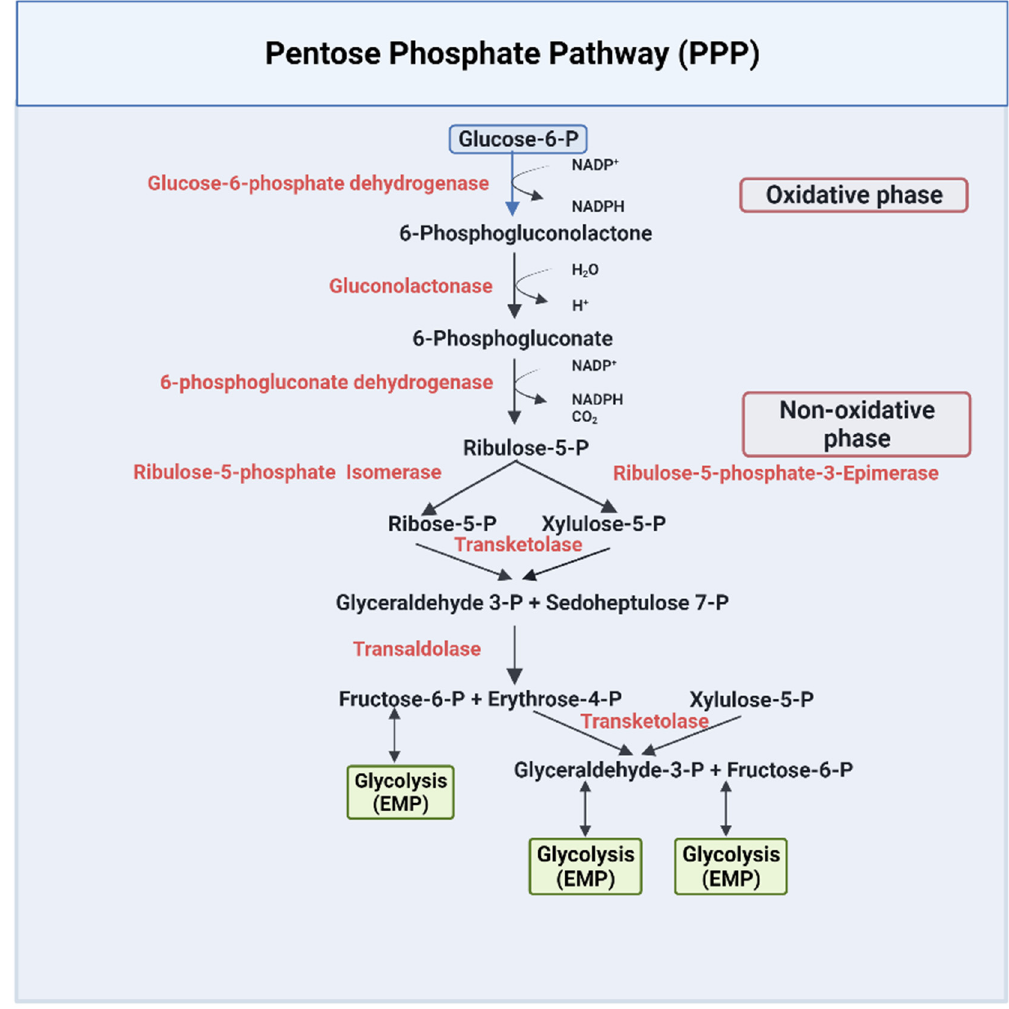
Figure 2. The pentose phosphate pathway [42,43,45,48].